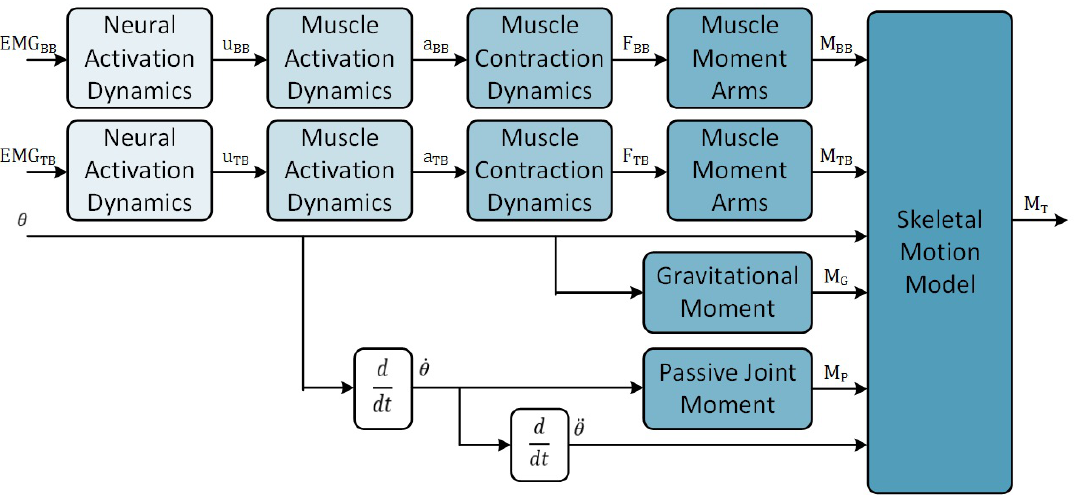
Figure 2. The developed elbow motion model uses EMG signals of the biceps brachii, EMG BB , and the triceps brachii muscles, EMG TB , combined with the current elbow angle to estimate the total joint torque of the elbow, M T . The two muscle torques are configured antagonistically within the skeletal motion model. M G is the moment caused by gravitational forces; M P is the passive joint torque; and θ , ˙ θ and ¨ θ are the joint position, angular velocity and angular acceleration,